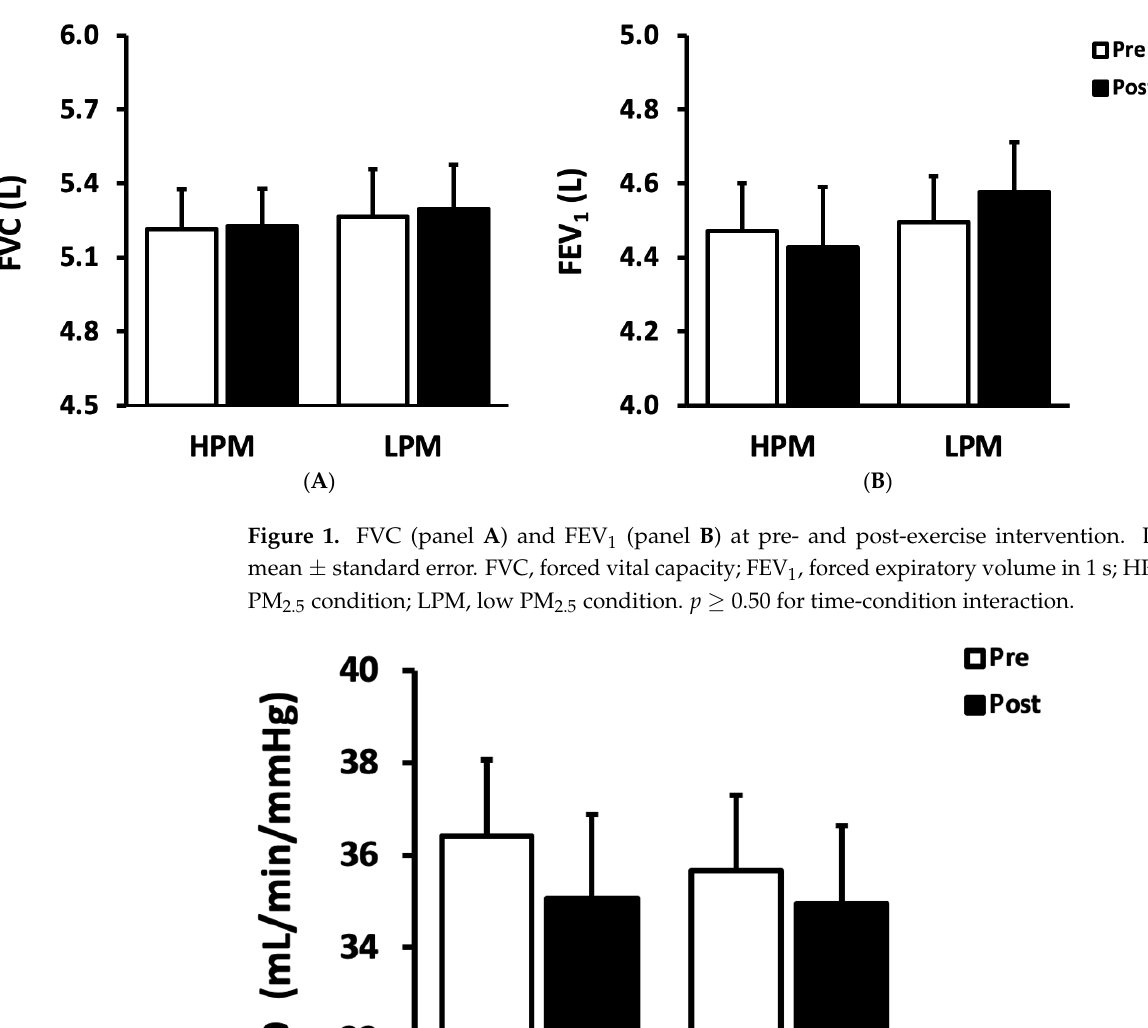
Figure 2. DLCO at pre- and post-exercise intervention. Data are mean ± standard error. DLCO, dif- fusing capacity of carbon monoxide; HPM, high PM 2.5 condition; LPM, low PM 2.5 condition. p = 0.09 for time-condition interaction .